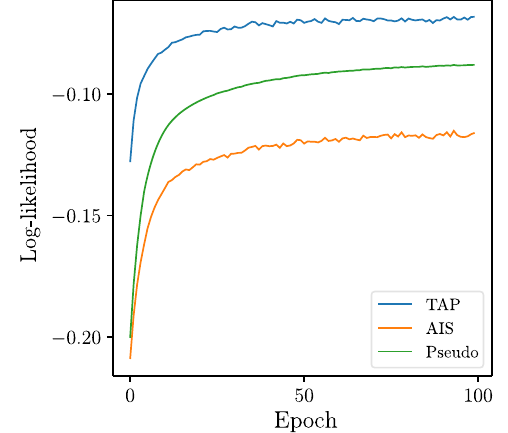
12. Comparison of the TAP log-likelihood to two other measures: the estimate provided by AIS and the (log) PL. All three measures are evaluated for the same sets of parameters, which correspond to the training of a binary-binary RBM using the TAP log-likelihood [see Fig. 3(a)]. The AIS results are averaged over 100 runs. For each run, 14 500 intermediate distributions are generated between the initial and target distri- bution using the same schedule as in Ref. [78]. The pseudolikeli- hood is computed using a stochastic approximation over 100 of the 784 pixels. Even though the training is performed so as to maximize the TAP log-likelihood, the AIS and PL estimates also increase, indicating the measures to be